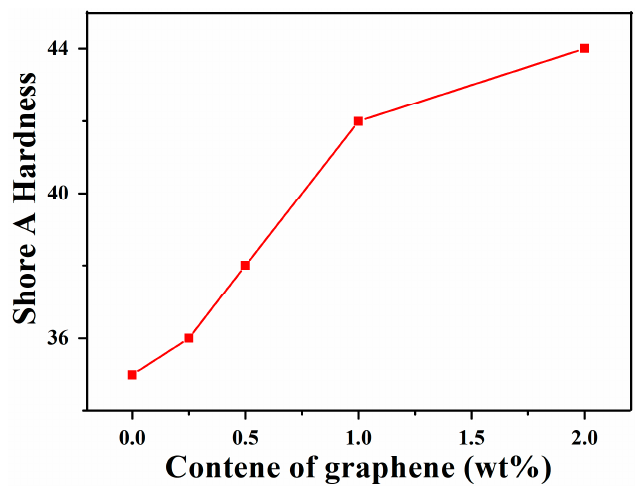
Figure 4. Shore A hardness of SIS and graphene/SIS composites.